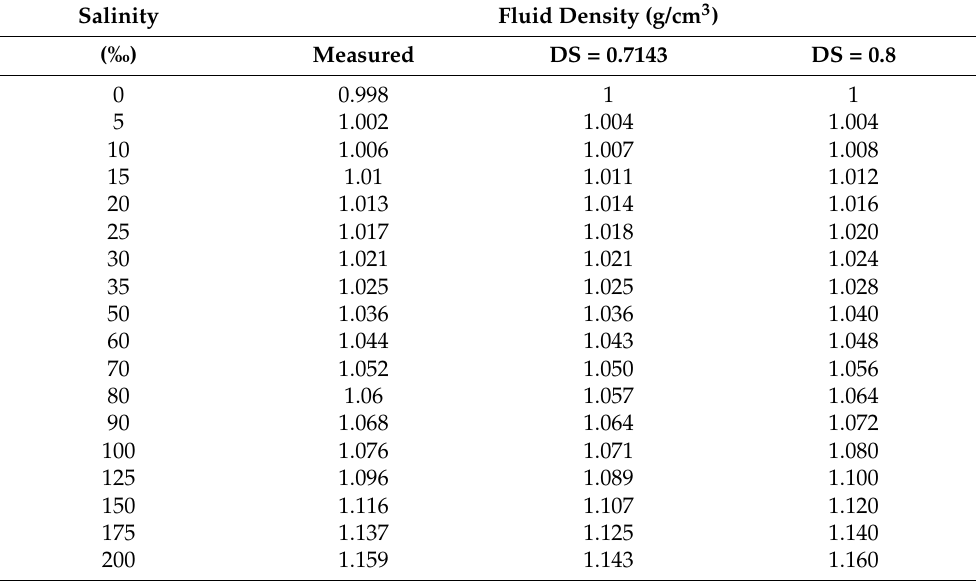
Table 2. Comparison of measured and estimated fluid density values (g/cm 3 ).